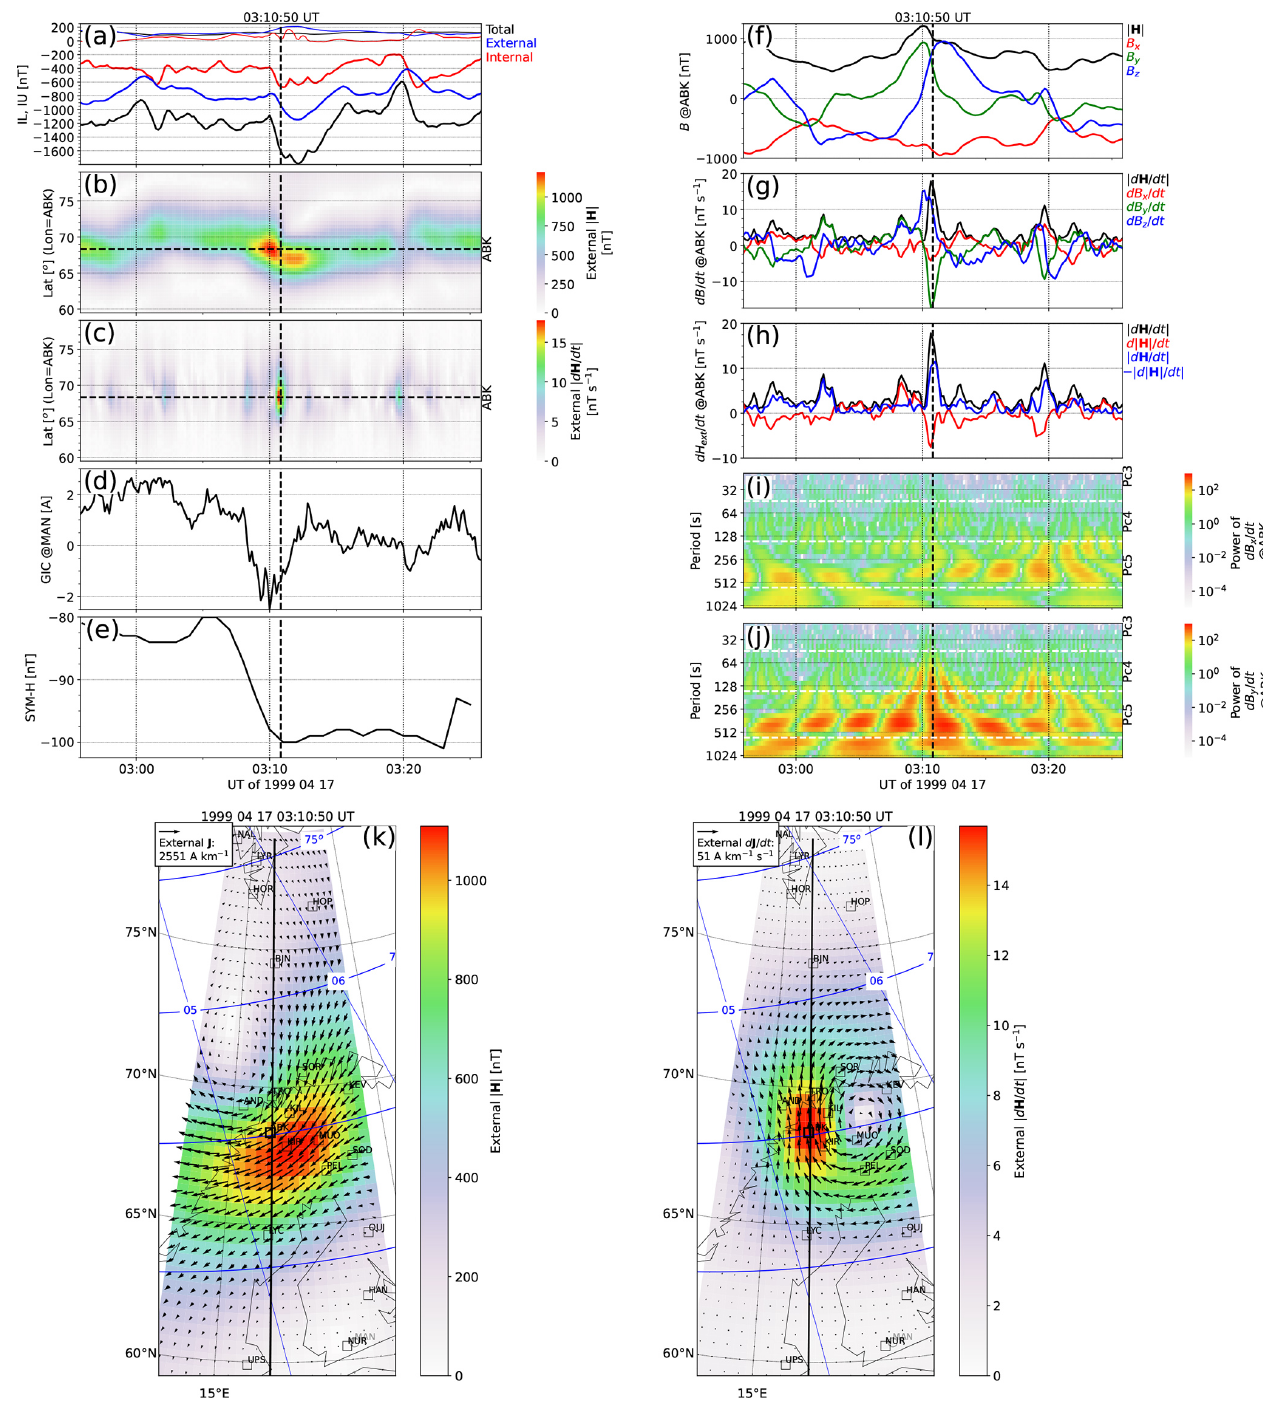
Figure 12. Data in a format similar to Fig. 5 ± 15min around the event on 17 April 1999 at 03:10:50UT.